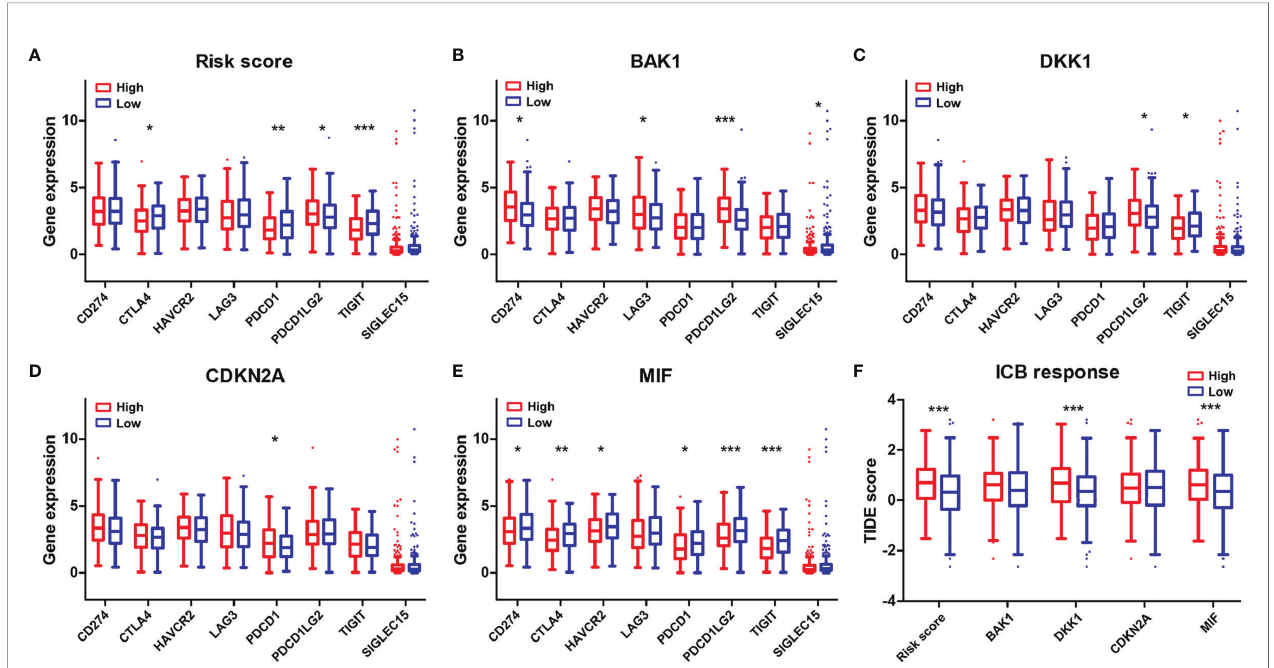
FIGURE 9 | Association of the four-AG signature with immune checkpoints and ICB response scores. (A – E) Comparison of eight immune checkpoint genes in the high and low subtypes strati fi ed by risk score (A) and expression levels of BAK1 (B) , DKK1 (C) , CDKN2A (D) , and MIF (E) . (F) Comparison of ICB response scores according to risk score (A) and expression levels of BAK1 , DKK1 , CDKN2A , and MIF . * p < 0.05, ** p < 0.01, and *** p <